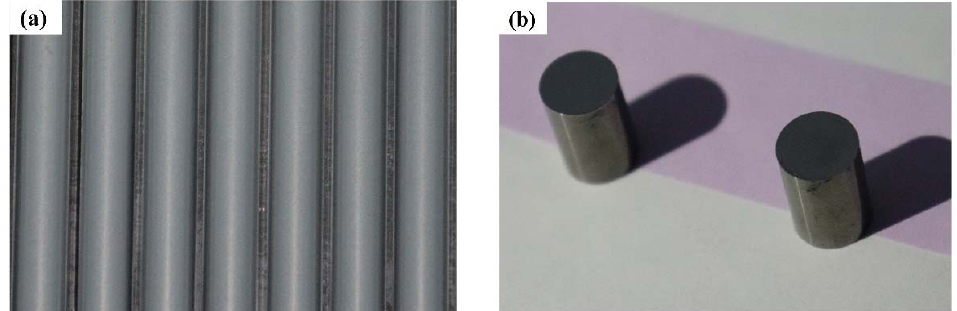
Table 2. Composition of WC/Co cemented carbide sample.